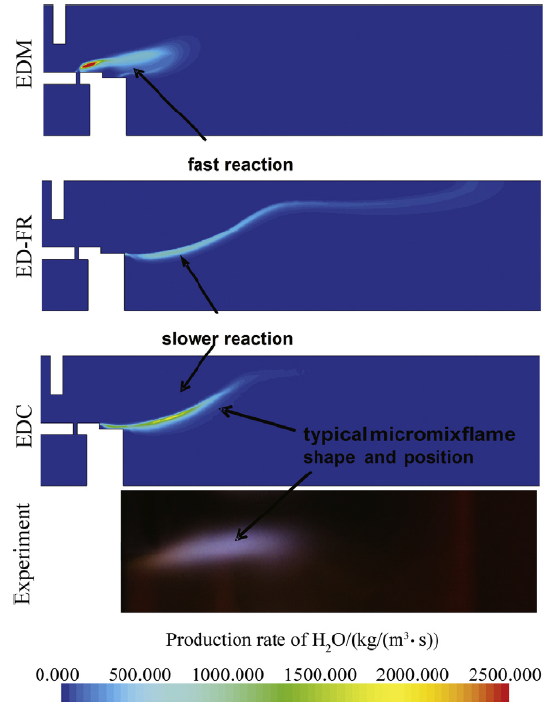
Figure 13. Experimental and numerical study of the dry-low-NOx hydrogen micro-mix combustion chamber by Ayed et al. [24]. Calculated reaction rates in comparison with visual flame